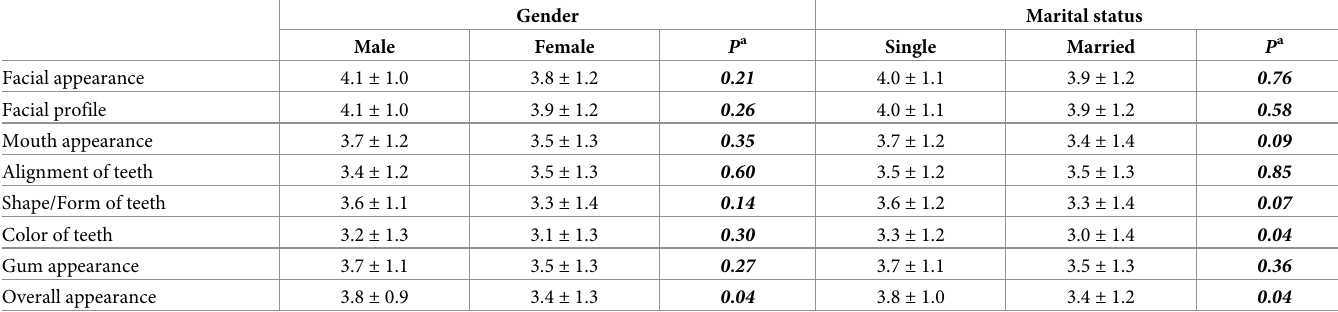
Table 3. Responses to OES-Ar questionnaire according to gender and marital status.